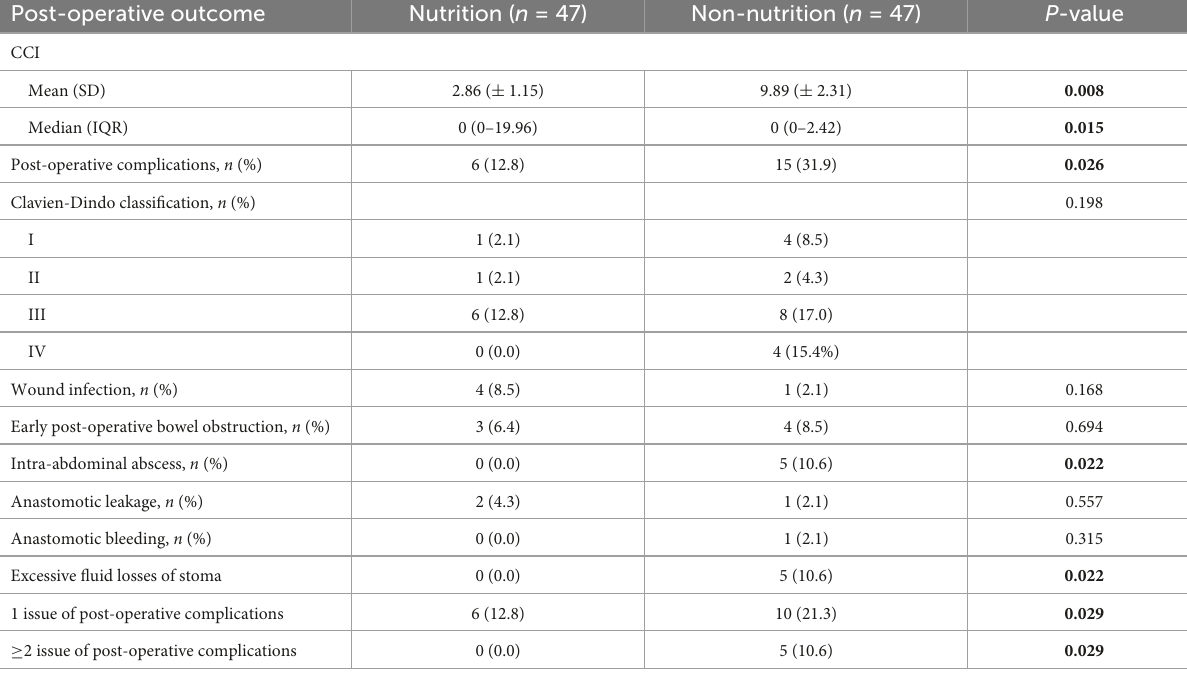
TABLE 5 Post-operative complications and perioperative